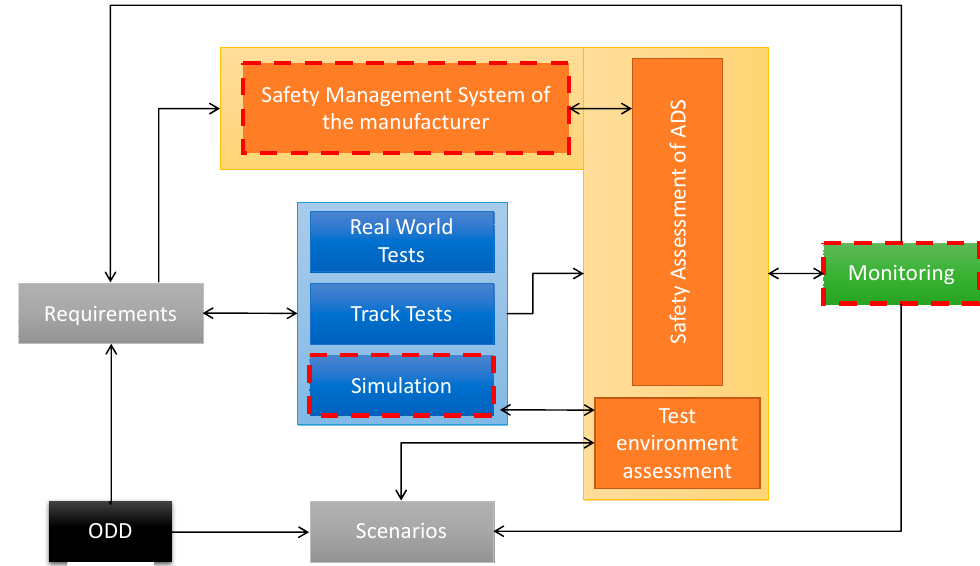
Figure 1. The multi-pillar approach. Authors’ own elaboration based on the NATM guideline document [6]. Surrounded by red-dotted line blocks are the novelty aspects of the newly conceived certification framework. The light-blue background encompasses the “testing” pillars (i.e., real-world, track-test, and simulation). The light orange L-shaped box is instead representative of provisions to be fulfilled via an Audit phase (i.e., the manufacturer’s SMS, the Safety Assessment of the ADS, and the assessment of the test environment).